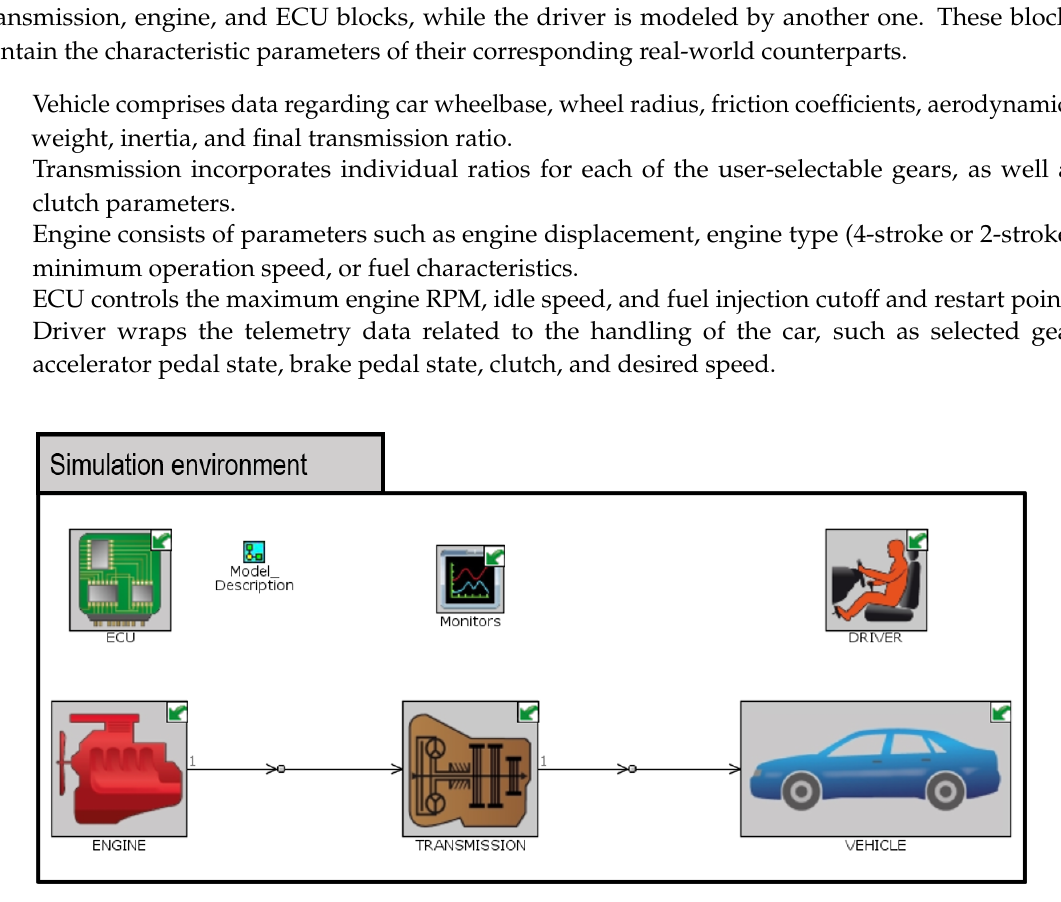
Figure 4. Block diagram of real-world telemetry-based fuel consumption simulation of Uyanik and wheelbase) and telemetry (gas pedal, brake pedal, speed, selected gear, and accelerations) as inputs. The model returns the simulated fuel flow as